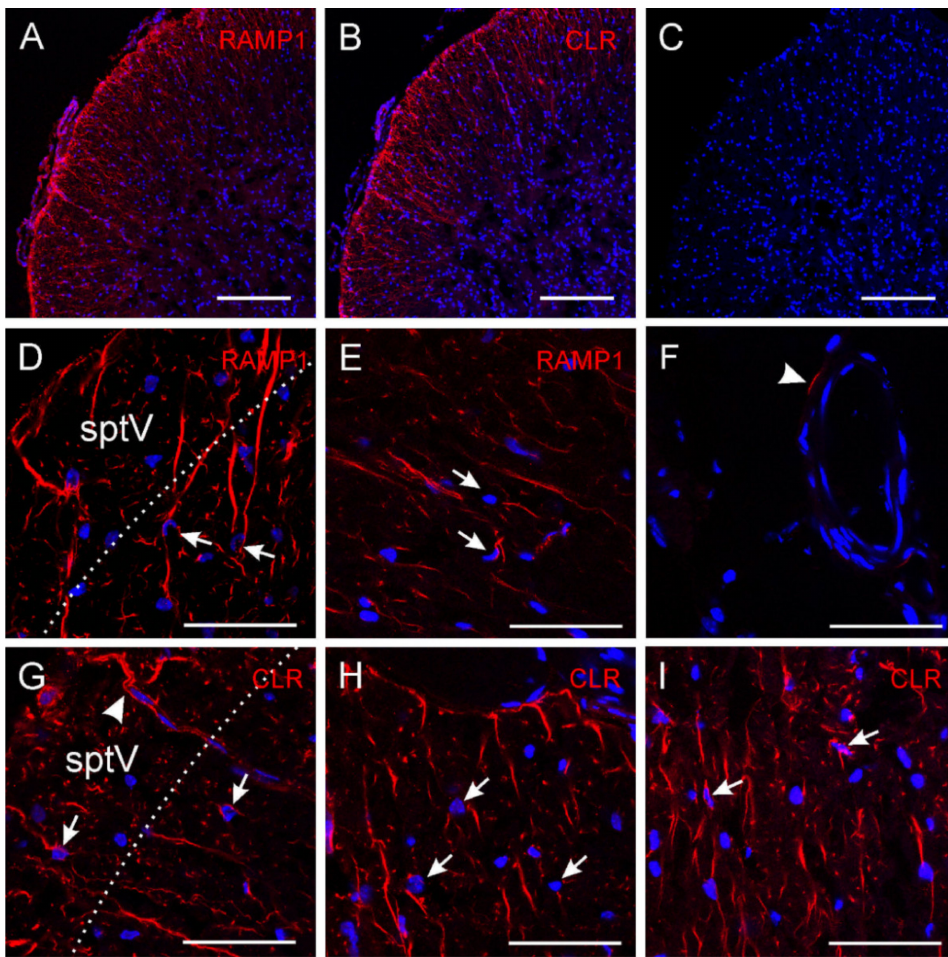
Figure 6. Immunohistochemically processed sections showing the outer laminae of the mouse dorsolateral Sp5C. Immunofluorescence of CGRP receptor components receptor activity modifying protein 1 (RAMP1) ( A , D , E ) and calcitonin-like receptor (CLR) ( B , G – I ) in the spinal trigeminal tract (sptV) and lamina I/II of the mouse Sp5C (( A – C , G ) dorsolateral, ( D , I ) ventrolateral, ( E , H ) lateral); ( C , F ) are control stainings without first antibody but incubated with the second antibody Cy3; blue is nucleus staining (DAPI). The dotted lines in ( D , G ) show the approximate border between sptV and lamina ( I ). Arrows point to cell bodies that are closely approached by RAMP1/CLR immuno-positive nerve fibres, the arrowhead in G shows CLR immuno-positive fibres accompanying a penetrating medullary blood vessel, and the arrowhead in the control staining F points to an unspecific immunofluorescence in the wall of a blood vessel; magnification bars 200 µ m in ( A – C ) and 50 µ m in ( D – I ). No CGRP receptor component immunofluorescence of cell bodies is